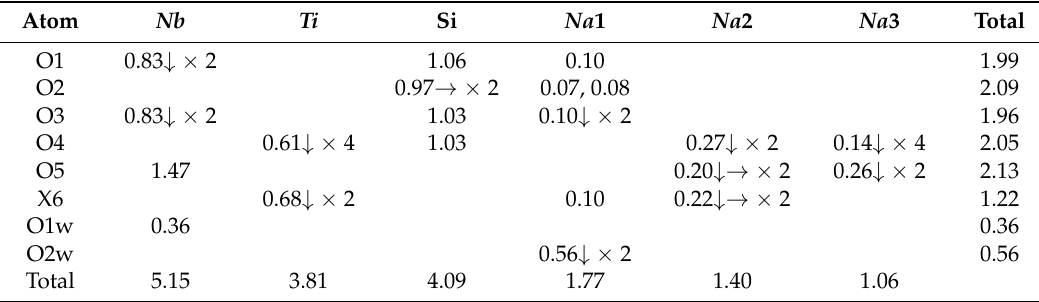
Table 6. Bond-valence analysis (v.u. = valence units) for